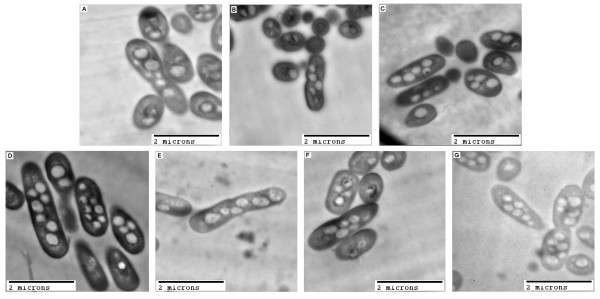
Electron micrographs ofR.eutrophastrains after ~22 h of growth in PHB production medium: (A) H16 (wt), (B) Re1097 (ΔphaZ1), (C) Re1107 (ΔphaZ5), (D) Re1110 (ΔphaZ2), (E) Re1112 (ΔphaZ1ΔphaZ2), (F) Re2005 (ΔphaZ1ΔphaZ2ΔphaZ3ΔphaZ5), (G) Re2006 (ΔphaZ3). Bar = 2 μm.